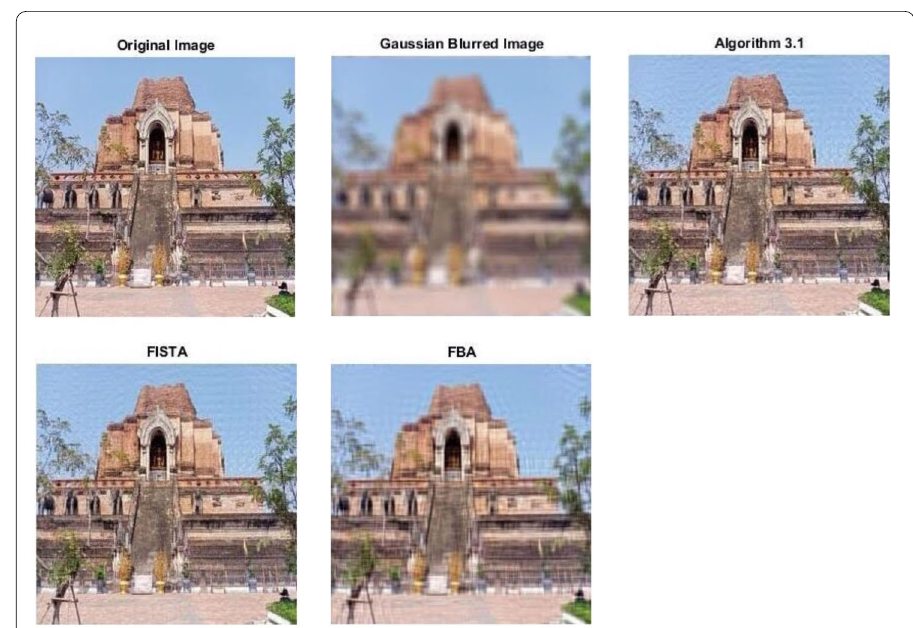
Figure 3 Results for Wat Chedi Luang’s deblurring image